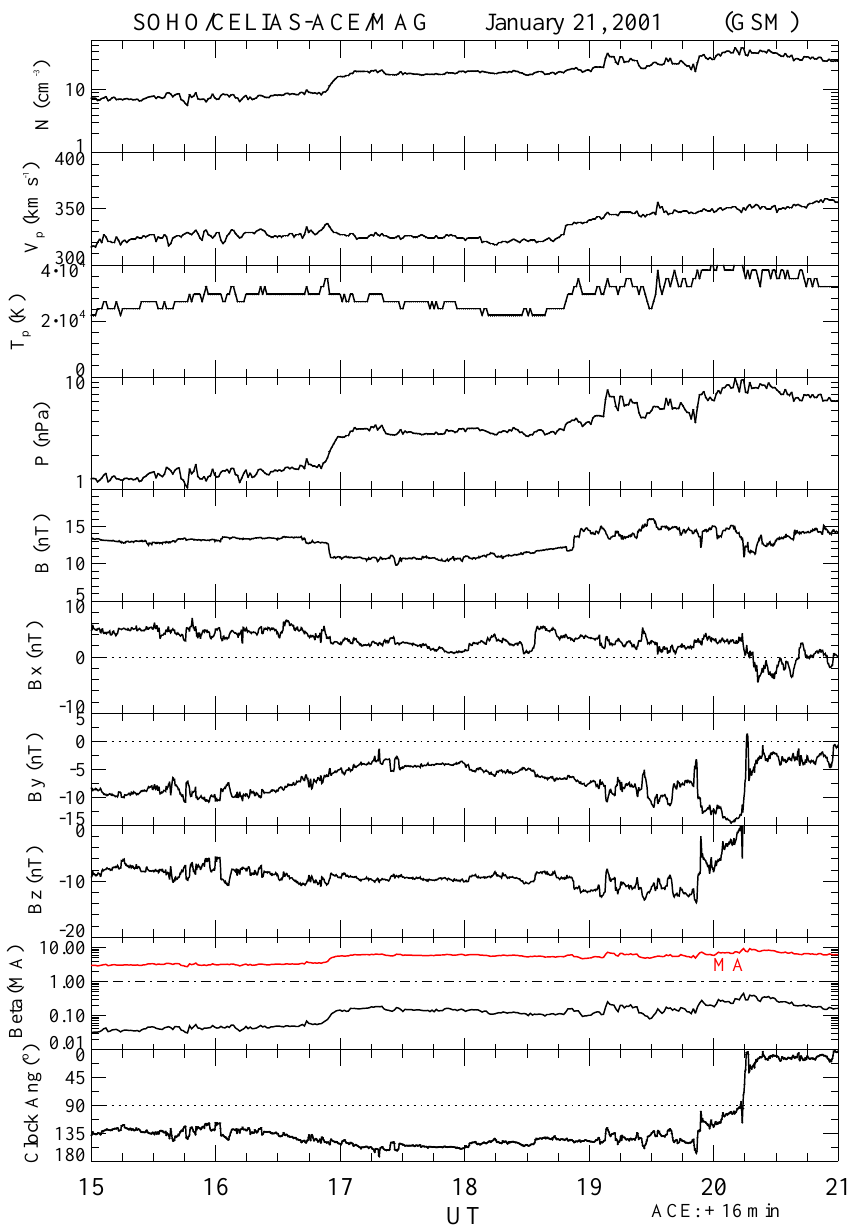
Fig. 18. Solar wind plasma and IMF data for the interval 15:00–21:00UT obtained from spacecraft SOHO (plasma) and ACE (magnetic field), respectively. Same format as in Fig.